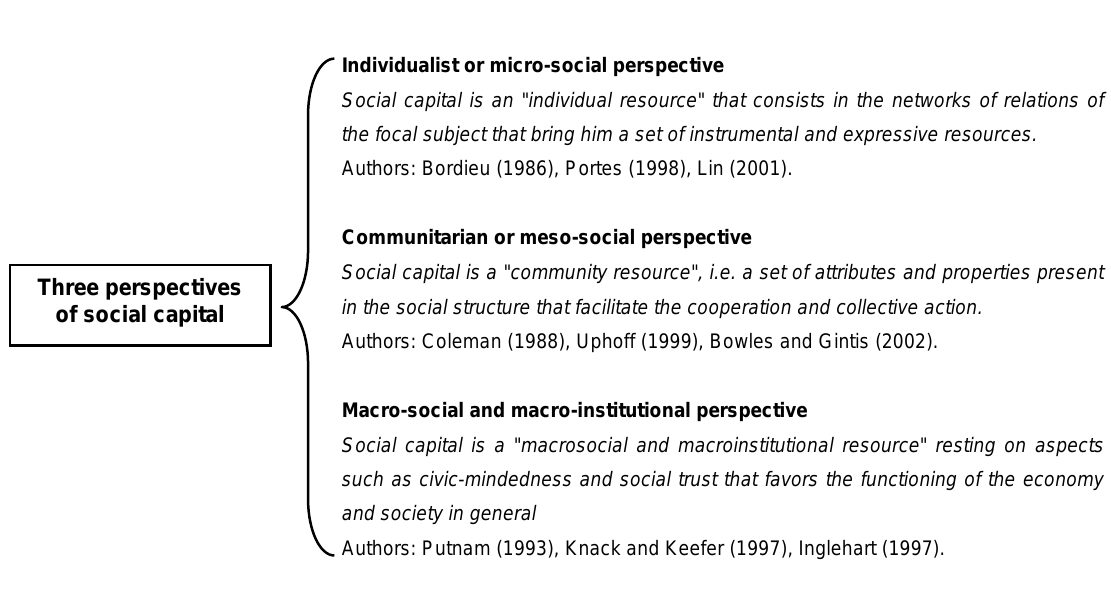
Figure 2 . The three perspectives of social capital.